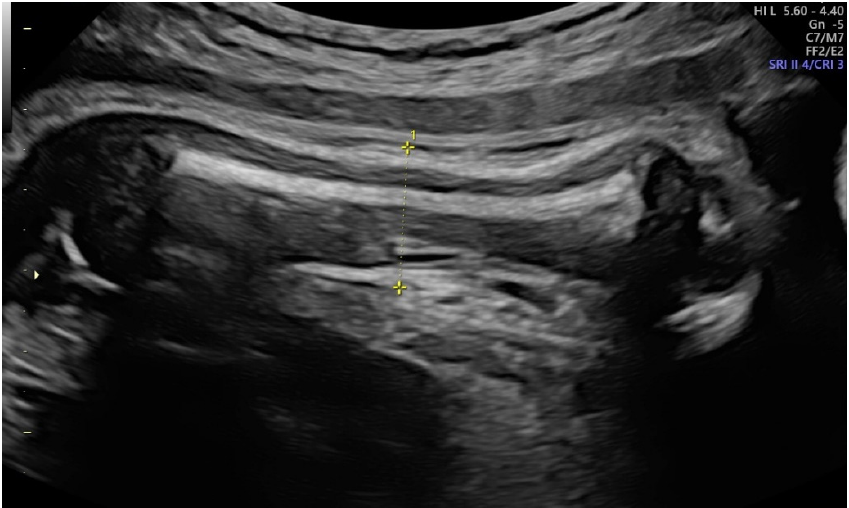
Figure 1. Mid-arm diameter, evaluated placing the caliper from skin to skin on the upper arm near the heart.